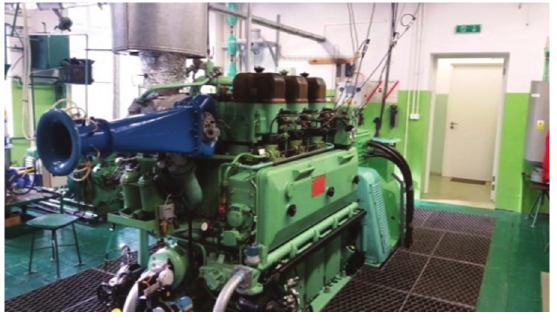
Fig. 1. SULZER 3AL25/30